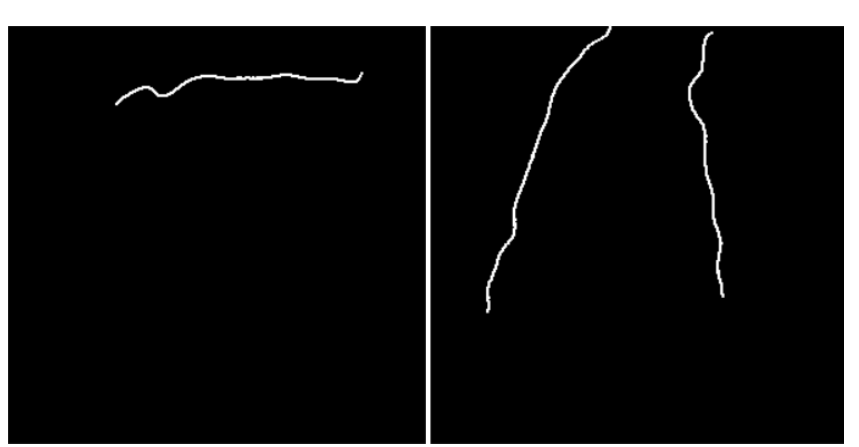
Figure 6. Candidate lines